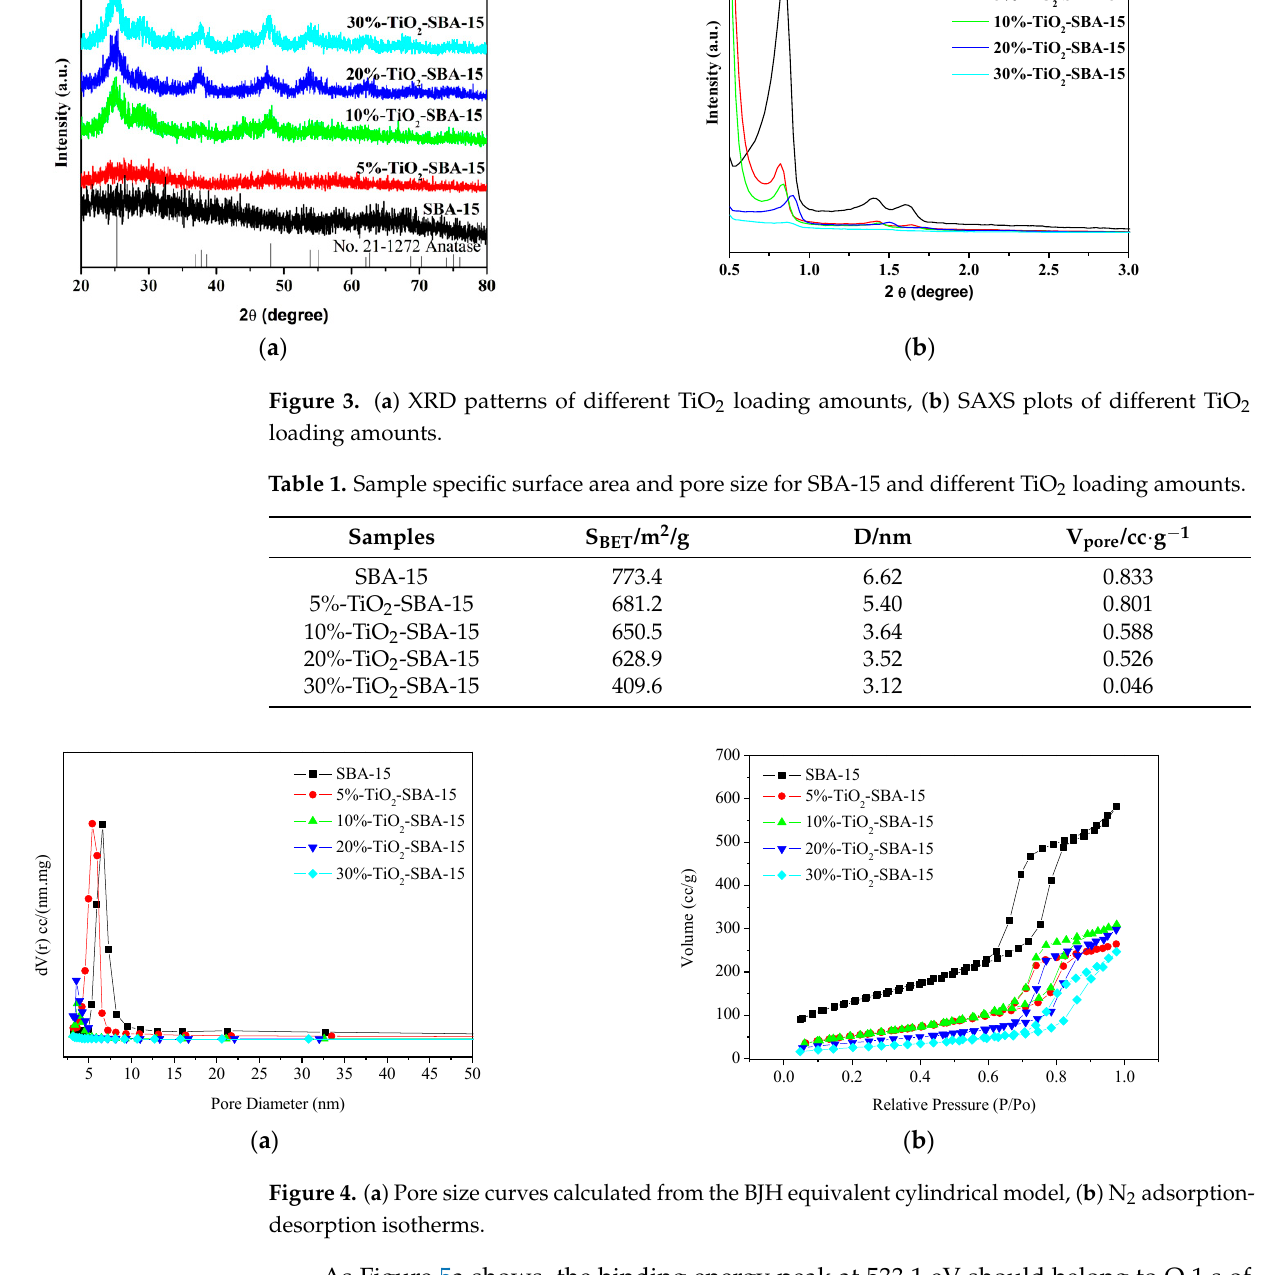
Figure 4. ( a ) Pore size curves calculated from the BJH equivalent cylindrical model, ( b ) N 2 adsorp- tion-desorption isotherms.